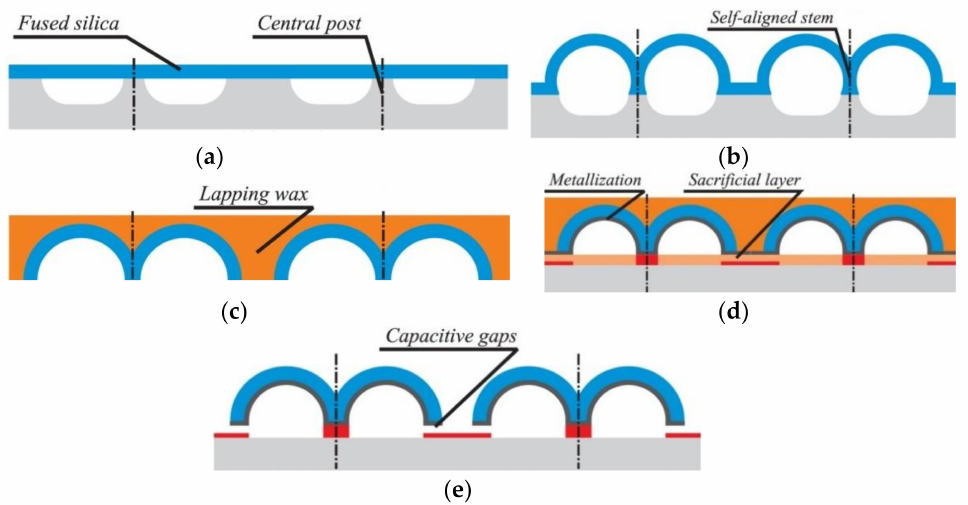
Figure 9. Step-by-step fabrication process of fused silica wineglass resonator using micro- glassblowing (Senkal et al. [75]) © 2022 IEEE. Reprinted, with permission from IEEE from D. Senkal, M. J. Ahamed, M. H. Asadian Ardakani, S. Askari and A. M. Shkel, “Demonstration of 1 million Q-factor on microglassblown wineglass resonators with out-of-plane electrostatic transduction”, Journal of Microelectromechanical Systems, vol. 24, no. 1, pp. 29–37, 2014. ( a ) Bonding wafer layer to